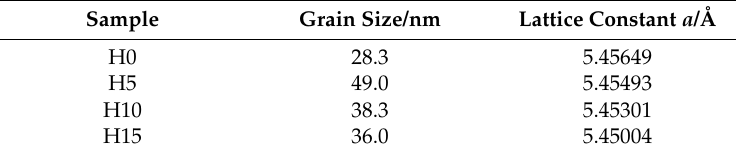
Table 1. Grain size and lattice constant of the samples prepared at different HNO 3 concentrations.